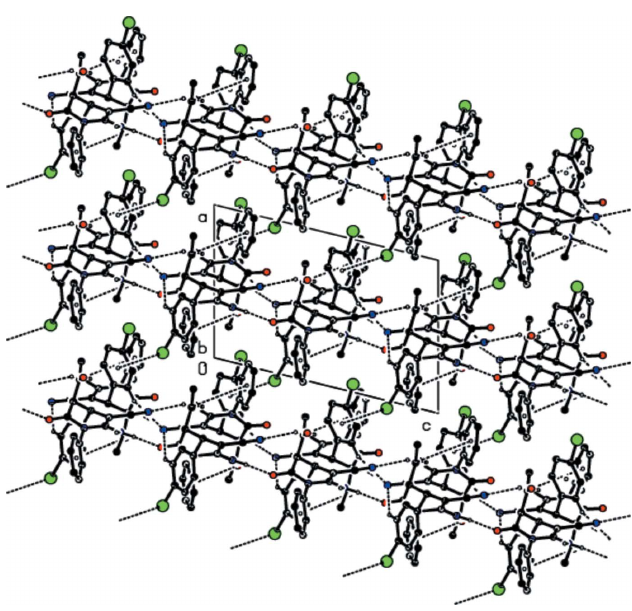
Figure 7 A view of the C—Br (cid:2)(cid:2)(cid:2) (cid:2) and C O (cid:2)(cid:2)(cid:2) (cid:2) interactions in the structure of the title compound viewed down the b axis. (Fig. 8 a , b , c , d ) indicate regions of N—H (cid:2) (cid:2) (cid:2) O interactions. The N—H (cid:2) (cid:2) (cid:2) N and C—H (cid:2) (cid:2) (cid:2) N interactions (Tables 1 and 2) also cause red spots on the Hirshfeld surfaces.